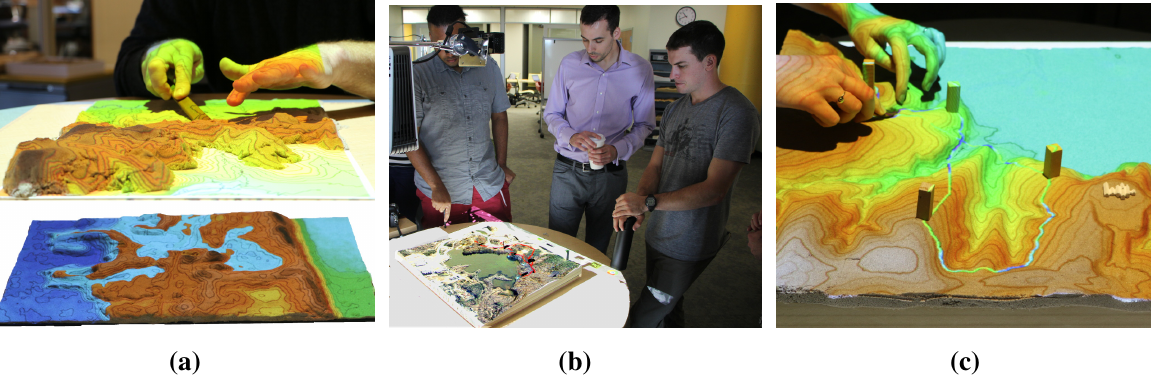
Figure 6. Students working on projects with Tangible Landscape: ( a ) ( top ) sculpting a sand model; ( a ) ( bottom ) simulating storm surge on the Outer Banks of NC; ( b ) designing a park on the North Carolina State University (NCSU) campus; ( c ) and exploring various options for the design of a trail.